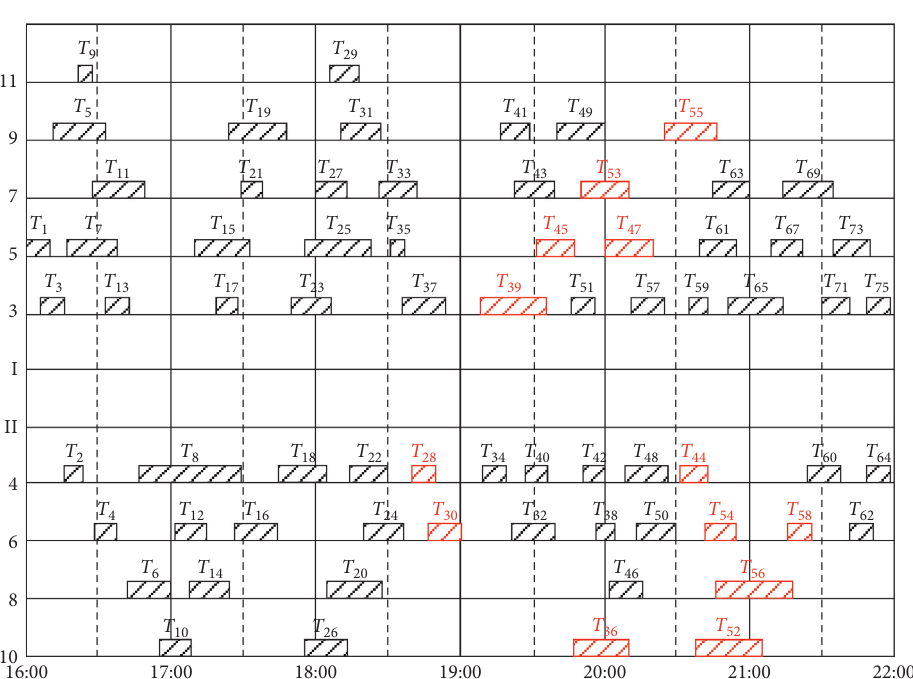
Figure 9: Platform track utilization scheme after the reoptimization using CPLEX-WV for the scenario (70, 10, 0).